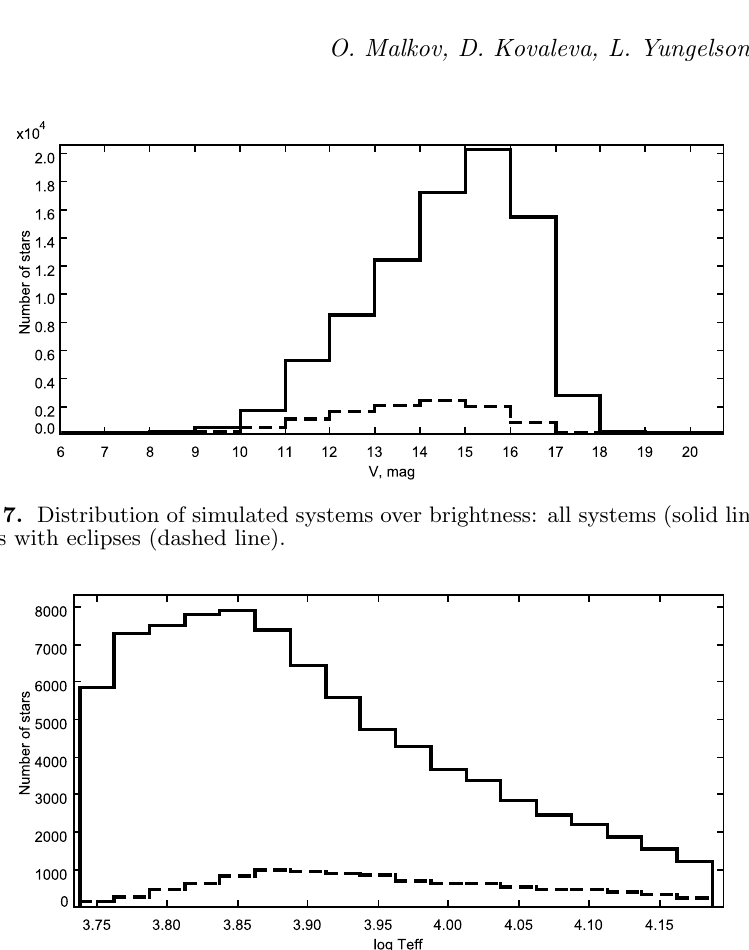
Fig. 8. Distribution of simulated systems over the accretor’s effective temperature: all systems (solid line) and systems with eclipses (dashed